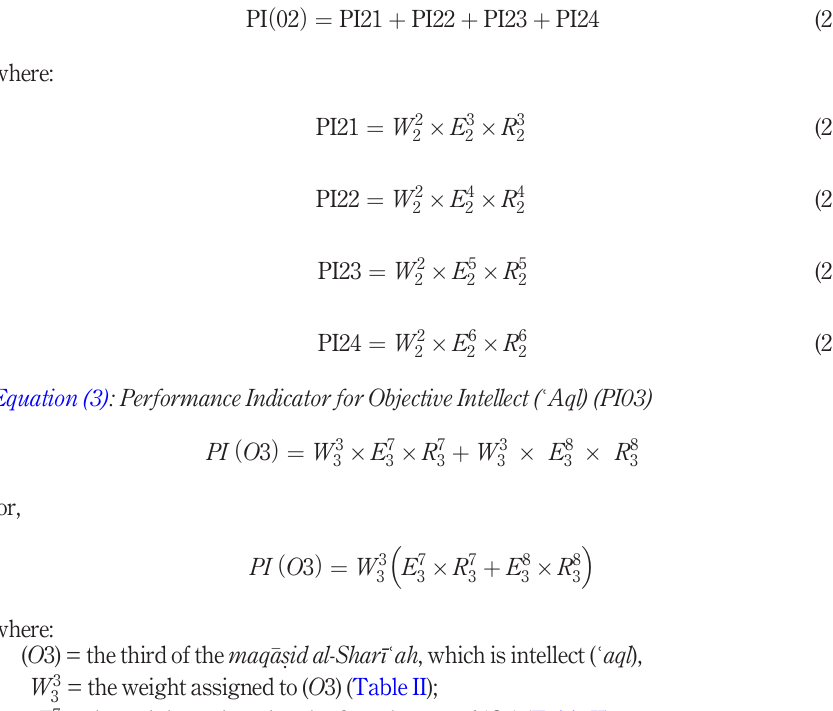
of ( O 3) (as applied 3